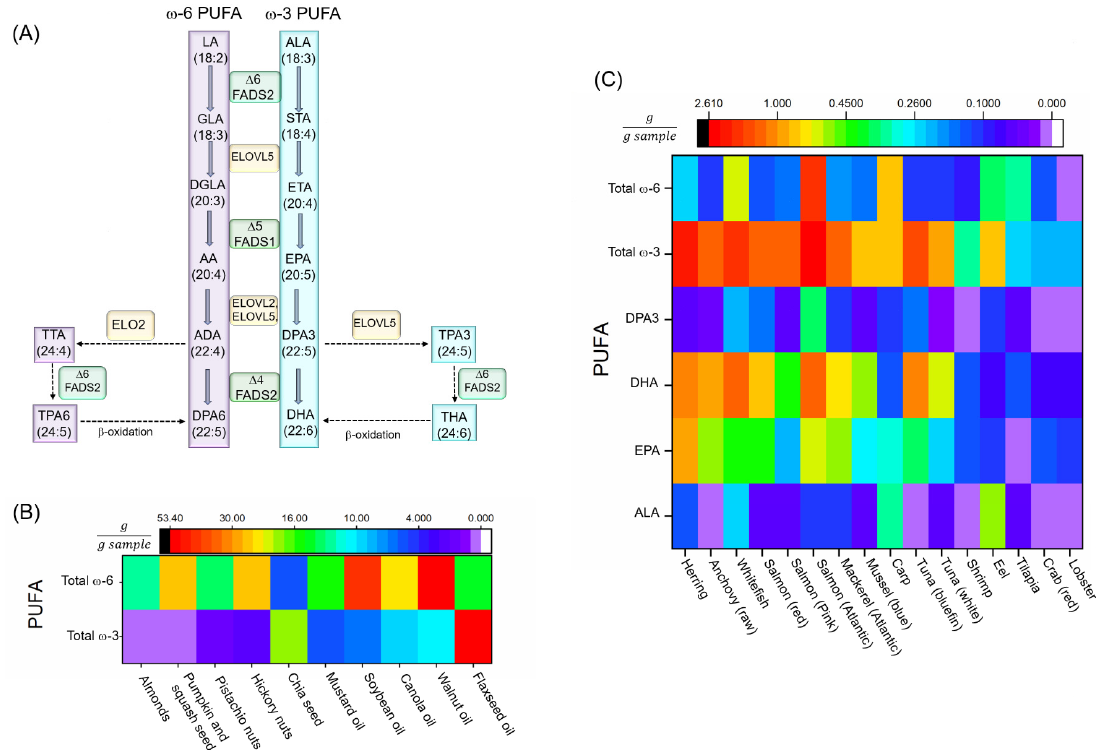
Figure 2. ( A ) PUFA biosynthesis pathways. ( B ) Common vegetable oil or seeds. The total ω -PUFA content is almost exclusively ALA, with little to no EPA, DHA, and DPA3 [47]. ( C ) PUFA amounts in different fish and seafood (all are cooked or baked unless otherwise mentioned) [47]. Abbreviations-